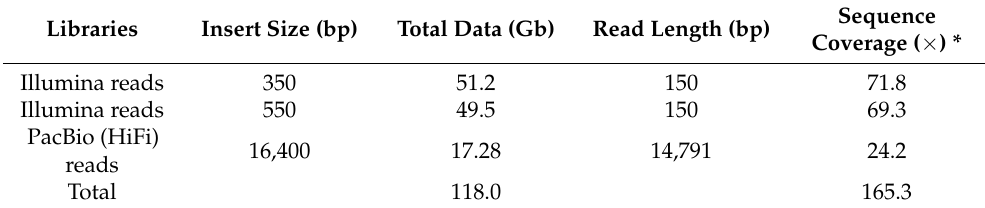
Table 1. Summary of sequencing data for striped catfish genome assembly.